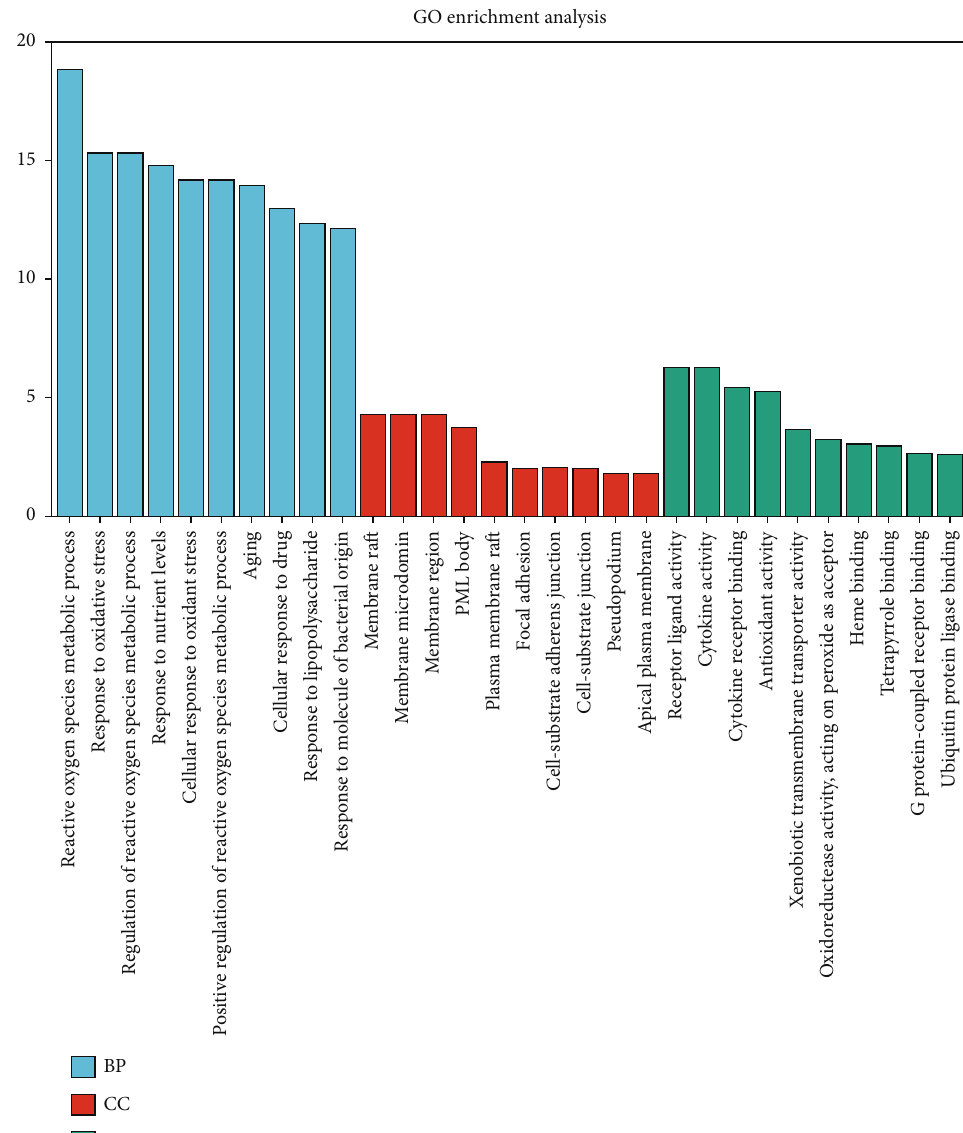
GAPDH was used as an endogenous control.